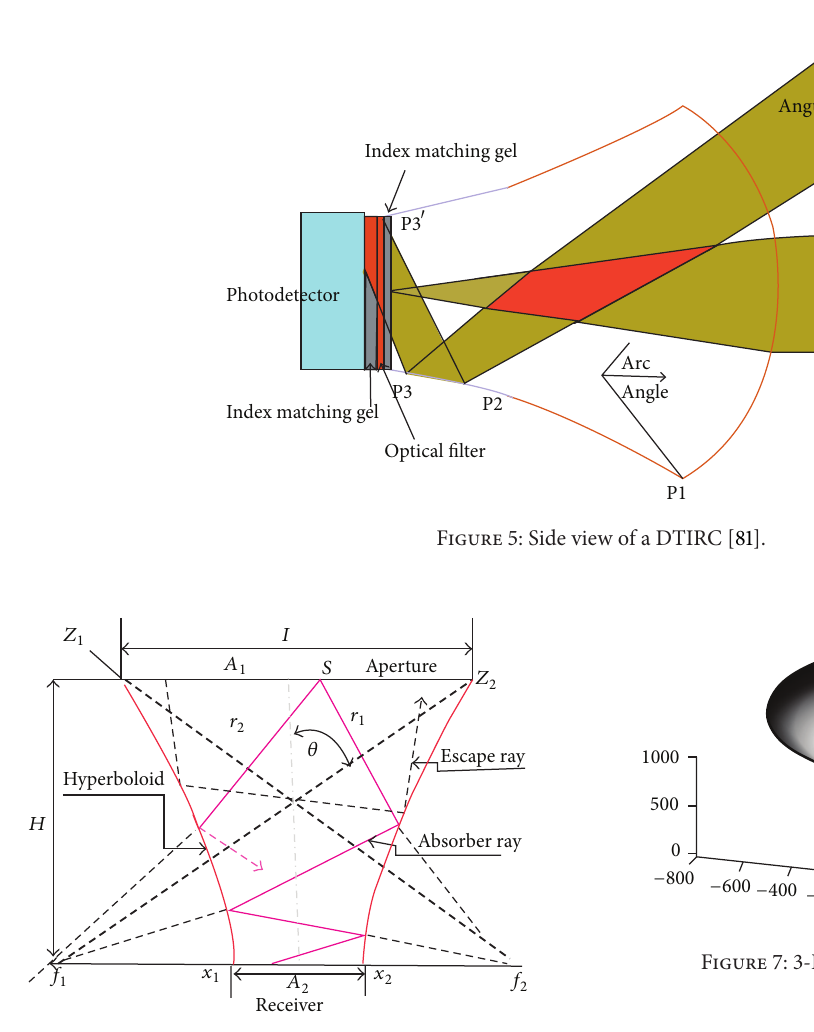
Figure 6: 2-D Hyperboloid concentrator [86].